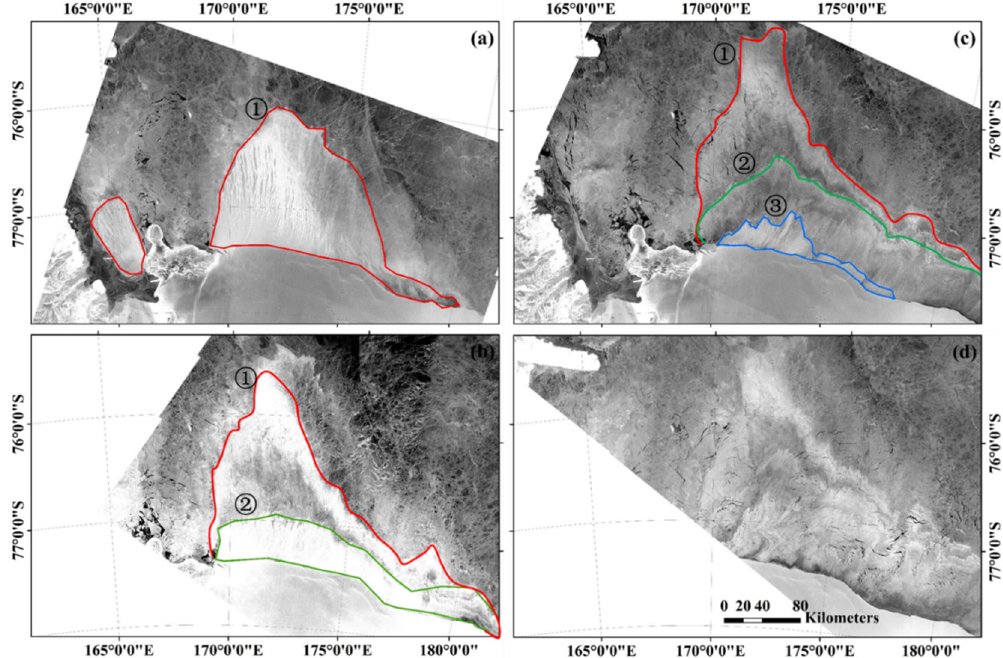
Figure 3. Sentinel-1 images in the Ross Sea on 17 September ( a ), 19( b ), 20( c ), 21( d ) in 2018. During these days, three katabatic wind events occurred. The first one occurred on 17 September (with the polynya area sketched as the red line ① ) and finished on 19 September. The second event occurred on 19 September (with the polynya area sketched as the green line ② ) and finished on 20 September. The third event occurred on 20 September (sketched as the blue line ③ ) and calmed down on 21 September when all traces, except the first one, are more diffuse.